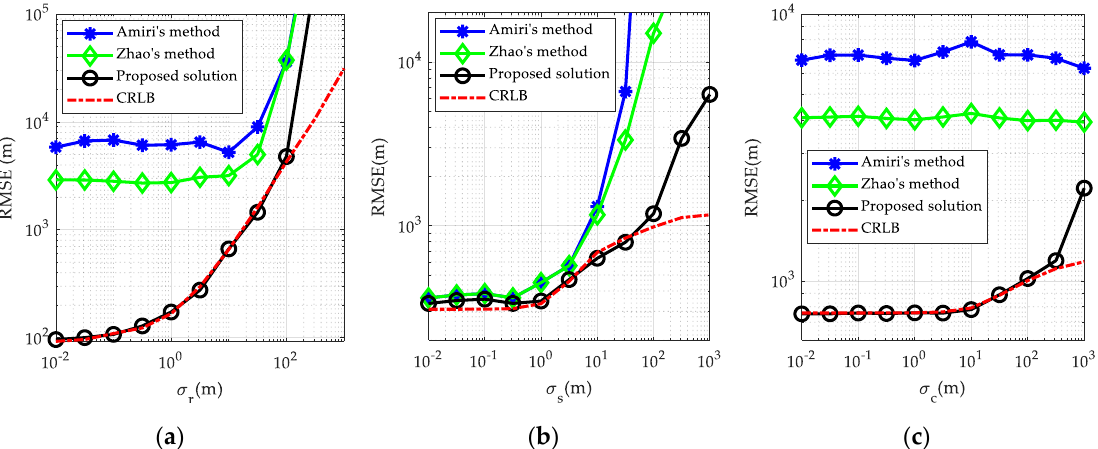
Figure 5. Comparison of the RMSEs among di ff erent localization methods in the far-field case: ( a ) with di ff erent BR measurement noise level σ r and σ s = 20 m, σ c = 10 m; ( b ) with di ff erent transmitter / receiver position error level σ s and σ r = 10 m, σ c = 10 m; ( c ) with di ff erent calibration target position error level σ c and r = 10 m, s = 20 m .